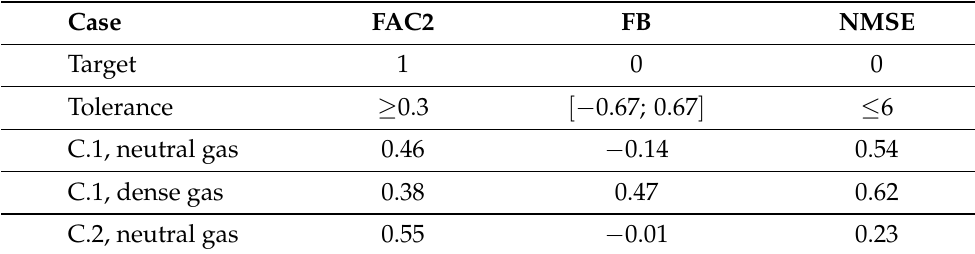
Table 7. Quality metrics for the urban area dispersion case. References according to Hanna and Chang